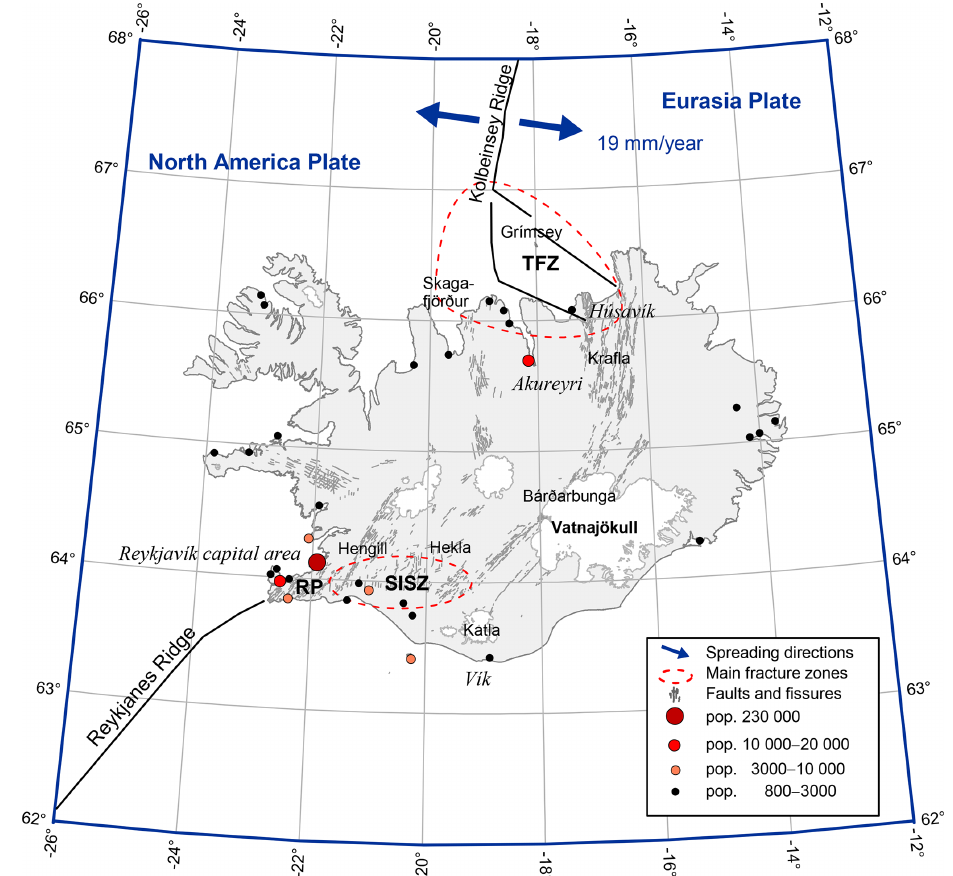
Figure 1. The ICEL region, 62–68 ◦ N, 12–26 ◦ W. The figure shows place names in Iceland mentioned in the article. Towns and villages with a 2020 population of at least 800 are also indicated as well as the Tjörnes Fracture Zone (TFZ), the South Iceland Seismic Zone (SISZ), and the Reykjanes Peninsula